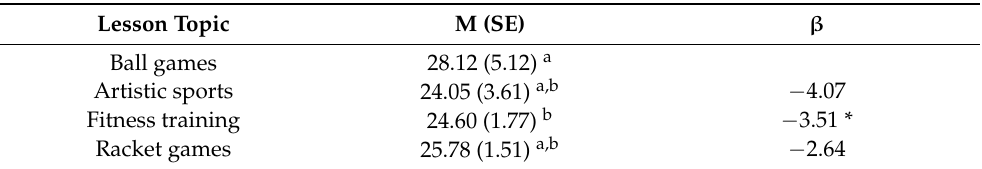
Table 2. Means and standard deviations in percentages of MVPA (percentage of class time) during PE as a function of lesson